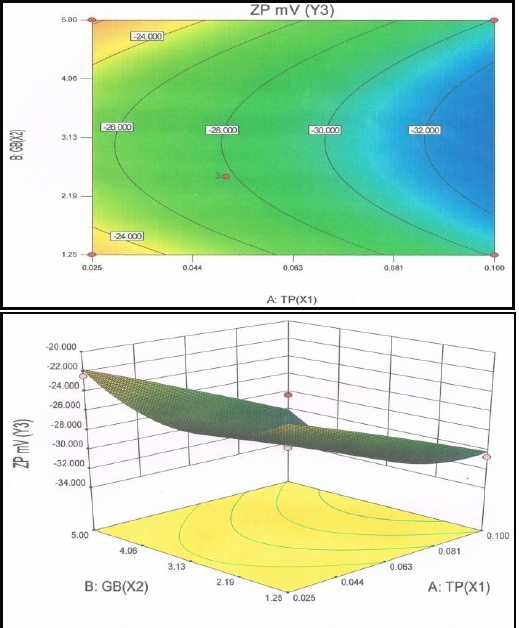
Figure 7: Response surface contour plot (Up) and 3D plot (down) for TP and GB effect on ZP